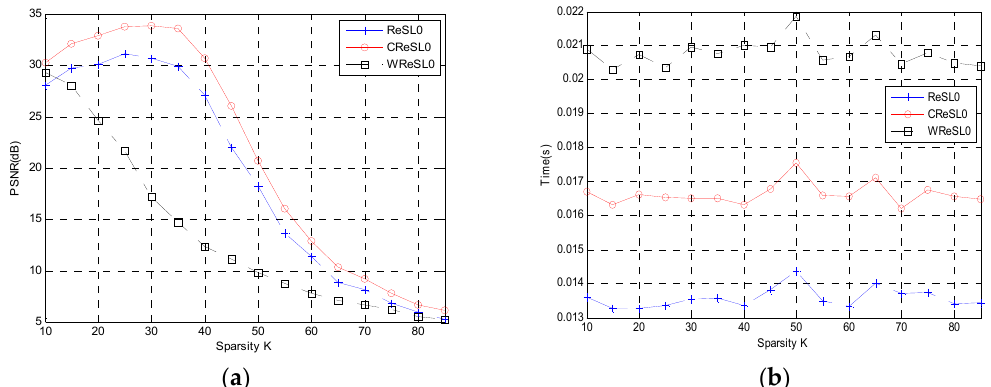
Figure 2. (a) Peak reconstruction signal-to-noise ratio (PSNR) values of each algorithm for different sparsities; ( b ) running time of each algorithm for different sparsities.